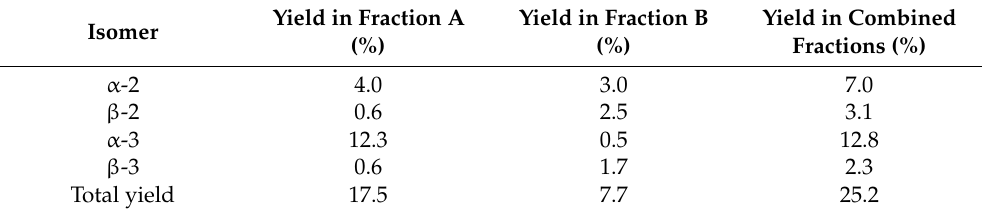
Table 4. The composition of fractions yielded in direct synthesis catalysed by hydrochloric acid. The composition of the combined fractions is discussed in the Results and Discussion